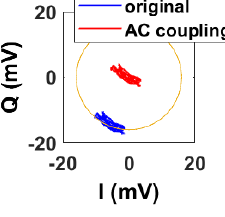
Figure 6. Example of baseband signals in the IQ plane obtained with the sub-10 GHz radar after applying the DC calibration methods. ( a ) AC coupling. ( b ) Linear demodulation. ( c ) Algebraic dis- tance. ( d ) Geometric distance.